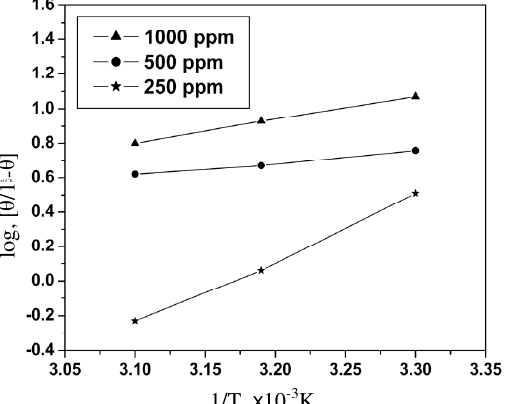
Figure 6. Arrehenius plots log ( θ / 1- θ ) vs. 1/T in 1 N H